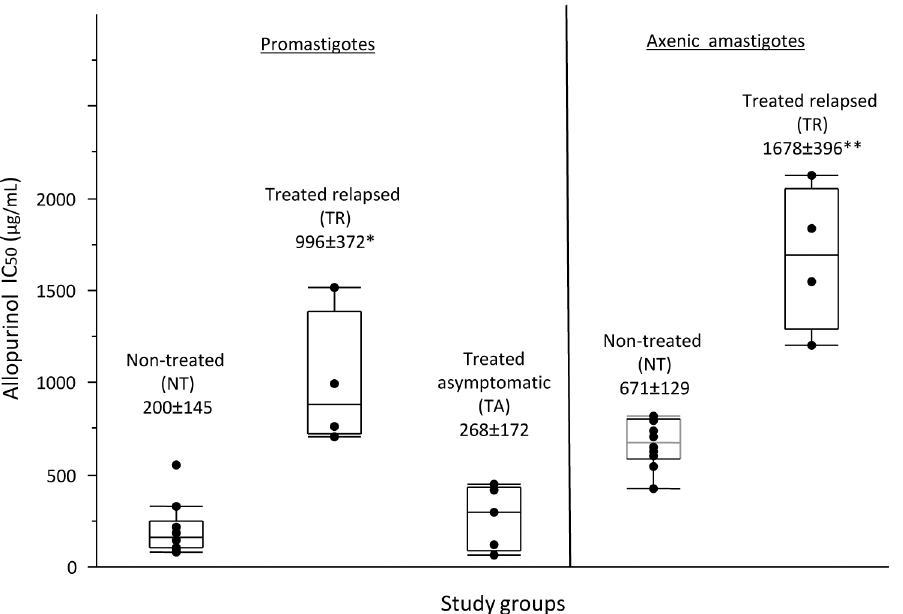
Fig 2. Average allopurinol IC50 values of promastigote and axenic amastigotes. Average allopurinol IC50 values found for promastigotes and axenic amastigotes of isolates from dogs in the study groups. Numbers in labels represent group mean ± STDEV. The TR group was found to have average IC50 values 5 and 2.5 times higher than the NT group for promastigotes and axenic amastigotes, respectively. * Represents significant difference between promastigote groups ( P = 0.01). ** Represents significant difference between axenic amastigote groups ( P = 0.002). Table 3. Allopurinol susceptibilities of intracellular amastigote strains. Outcomes are presented as percent inhibition in cultures treated with 300 μ g/mL allopurinol relative to untreated controls. Isolate § Average amastigote count per 100 macrophages Percent inhibition ¶ Treated